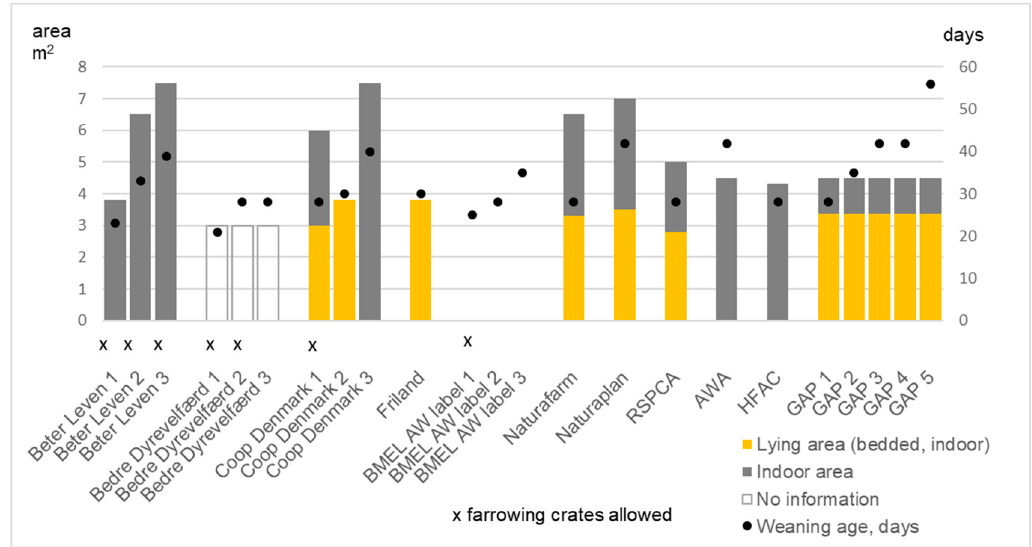
Figure 2. The size of farrowing place, the use of farrowing crates, and the minimum duration of suckling period, and hence the weaning age in 11 reviewed schemes. Label “Für Mehr Tierschutz” is not presented here as it did not consider farrowing issues other than prohibiting the use of the farrowing crate in tier 2. The EU pig directive [2] requires that piglets are not weaned before 21 days of age in the EU if they are moved into specialized housing. In organic production in the EU, piglets must not be weaned before 40 days of age [8].